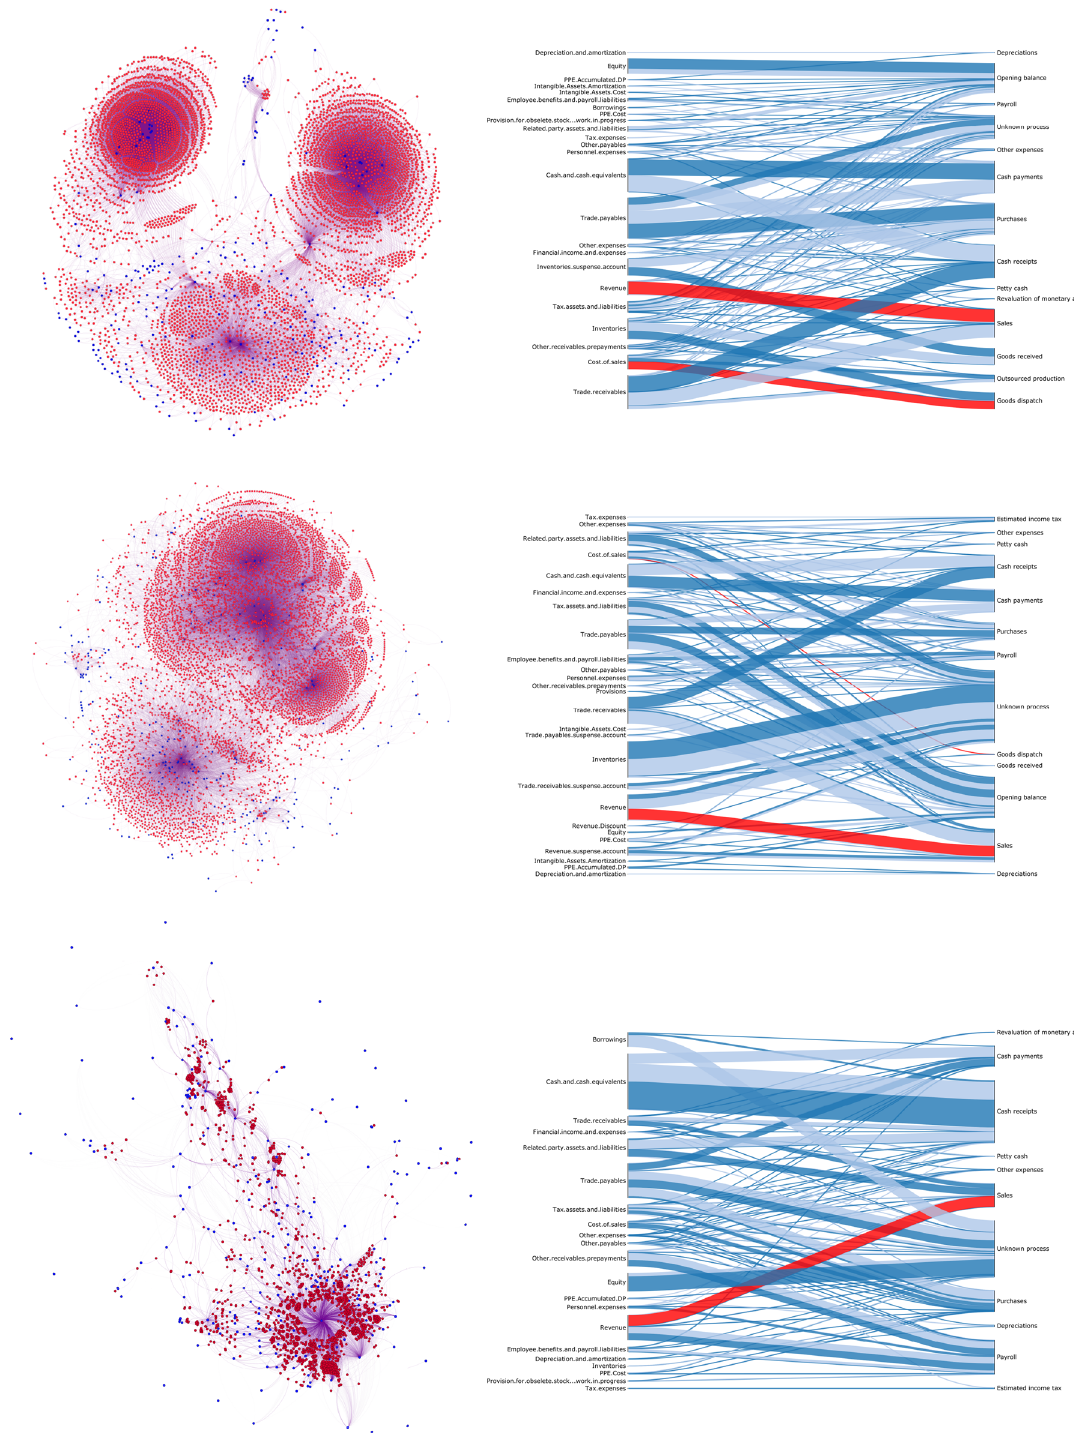
Figure 1. The two bipartite networks of three companies, the left side is the detailed network with financial account nodes in blue and business process nodes in red. On the right, the simplified bipartite network of the network on the left is displayed. In this network, we display on the left the financial accounts and on the right the business processes. In the simplified bipartite network the edge width represents the monetary flow. The dark blue represents outflows from financial accounts and the light blue represents inflows. The top left network is a new rendering of the same network as displayed in Boersma et al. 15